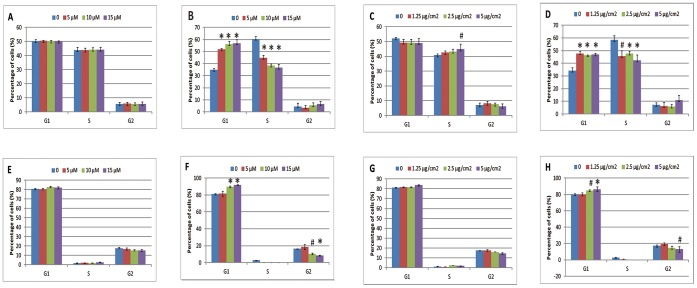
Cr (VI)-induced cell cycle arrest in two cell lines.The concentrations of potassium dichromate were 0, 5 µM, 10 µM, and 15 µM, and the concentrations of lead chromate were 0, 1.25 µg/cm2, 2.5 µg/cm2, and 5.0 µg/cm2. A–B:Percentages of human B lymphoblastoid cells at G1, S, and G2 phases after being exposed to potassium dichromate for 2 hours (A) and 24 hours (B). C–D: Percentages of human B lymphoblastoid cells at G1, S, and G2 phases after being exposed to lead chromate for 4 hours (C) and 24 hours (D). E–F:Percentages of A549 cells at G1, S, and G2 phases after being exposed to potassium dichromate for 2 hours (E) and 24 hours (F). G–H: Percentages of A549 cells at G1, S, and G2 phases after being exposed to lead chromate for 4 hours (G) and 24 hours (H). Hash keys above the bars: P<0.05 as compared with control; asterisks above the bars: P<0.01 as compared with control.